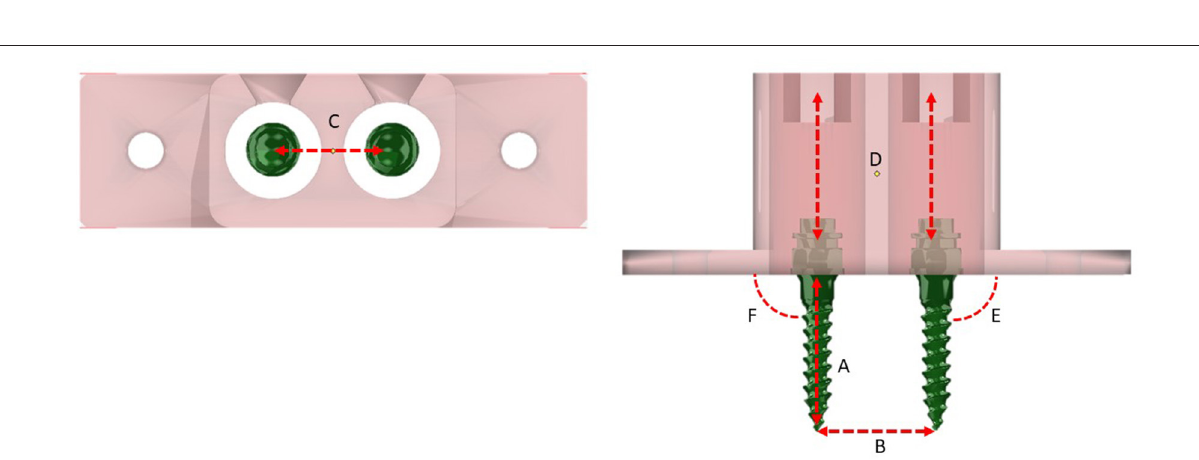
Frontiers in Dental Medicine | www.frontiersin.org 4 March 2022 | Volume 3 | Article